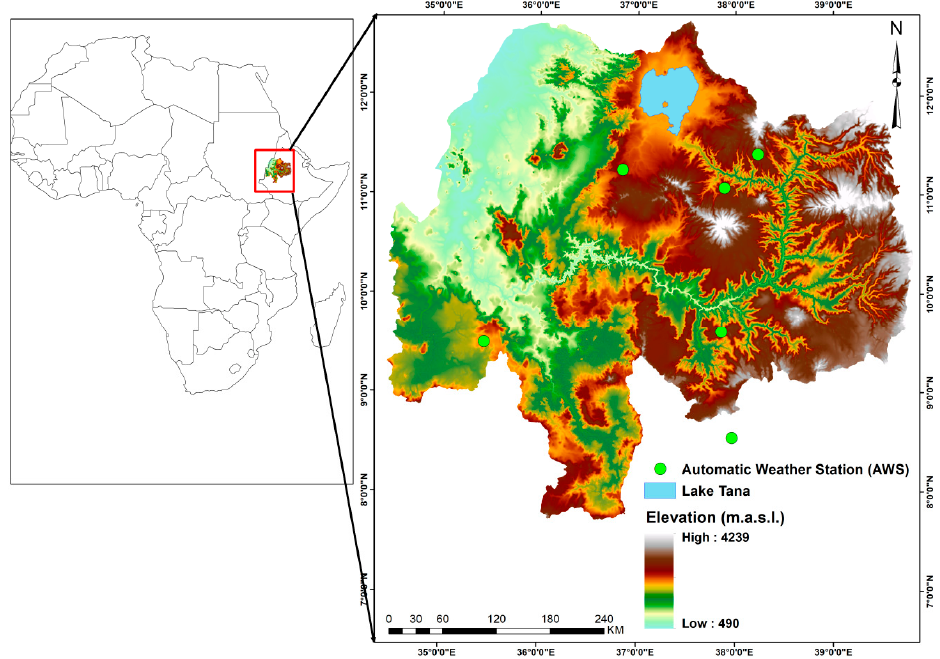
Figure 1. Digital elevation model (DEM) of the Upper Blue Nile basin and its location in Africa. The northeastern regions have higher elevation, while the northwestern regions have lower elevation (Imagery source: SRTM Global elevation data- https://earthexplorer.usgs.gov).